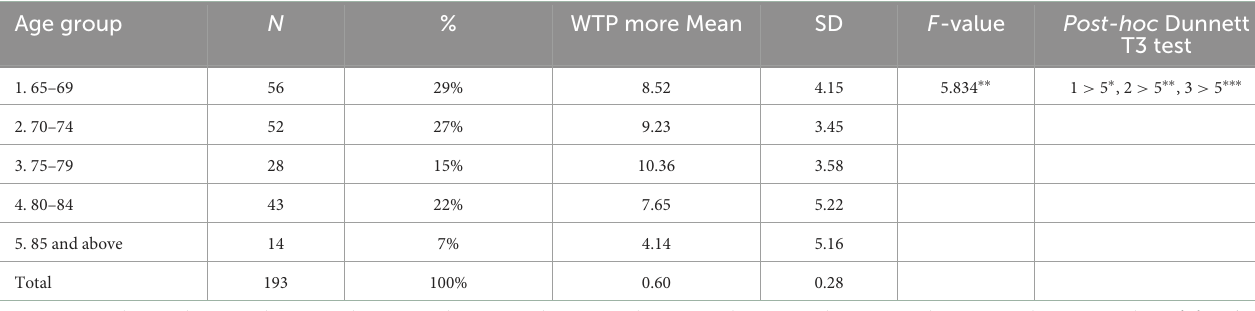
TABLE 4 WTP more comparison among five age groups.